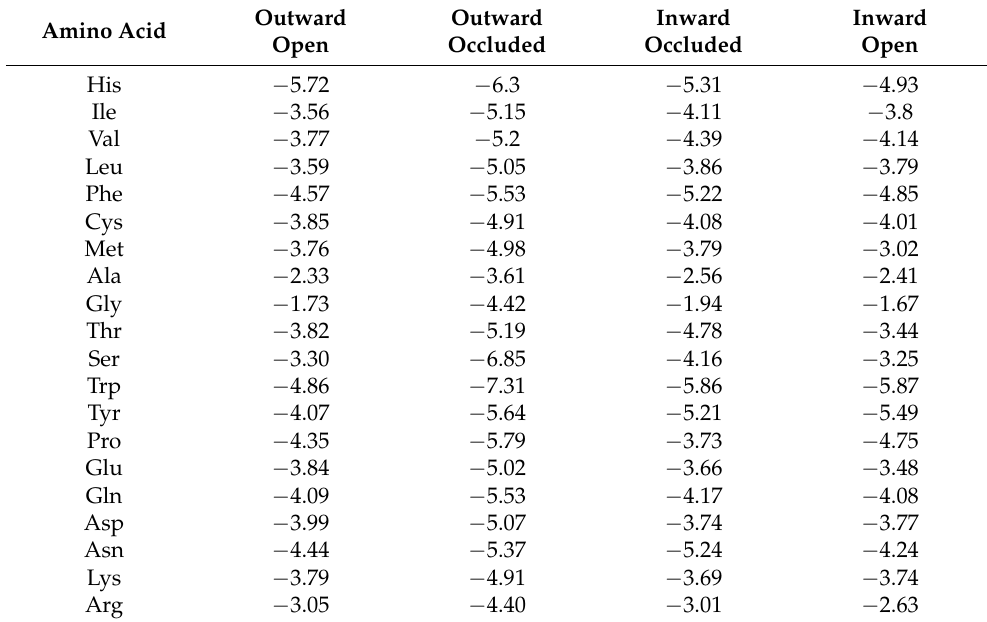
Inward Occluded